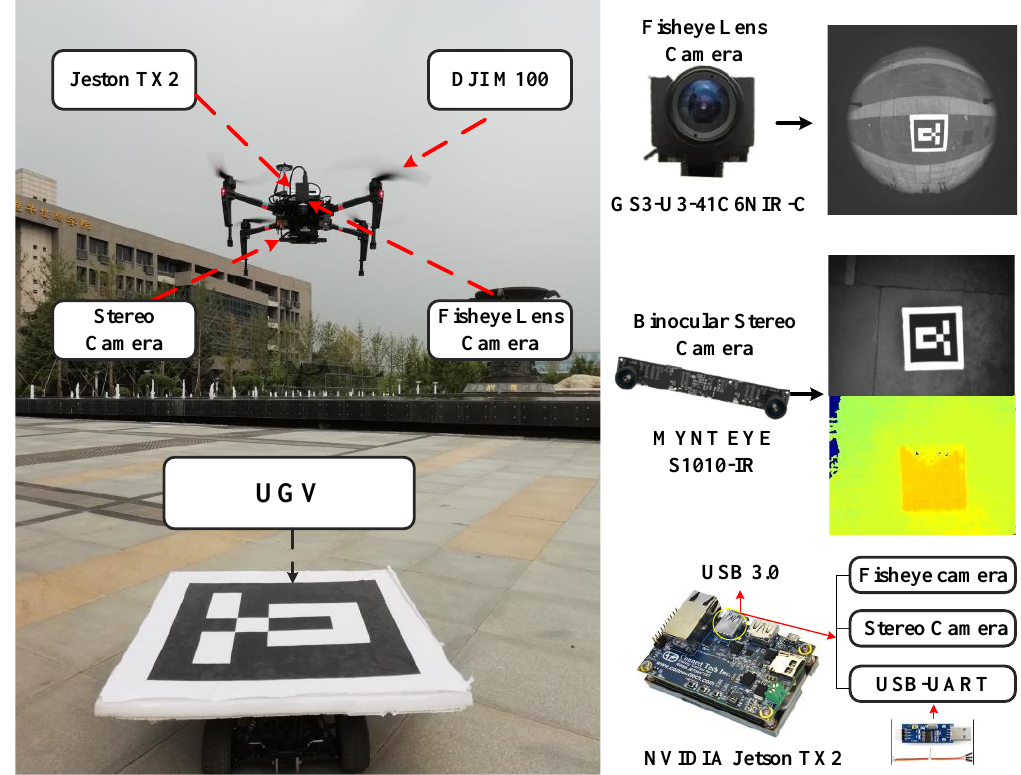
Figure 10. The autonomous landing system settings used in our experiments, including DJI-MATRICE, Jetson TX2, the fisheye lens camera and binocular stereo camera, and the remote-control vehicle. Both the fisheye lens camera and the binocular stereo camera are fixed to the body of the UAV without using a camera pan/tilt. The first one is tilted down by 90 ◦ for wide FOV target seeking, providing an image resolution of 512 × 512 pixels; the second binocular stereo camera is also downward-looking to locate the moving UGV, and the resolution is 752 × 480 pixels. For the